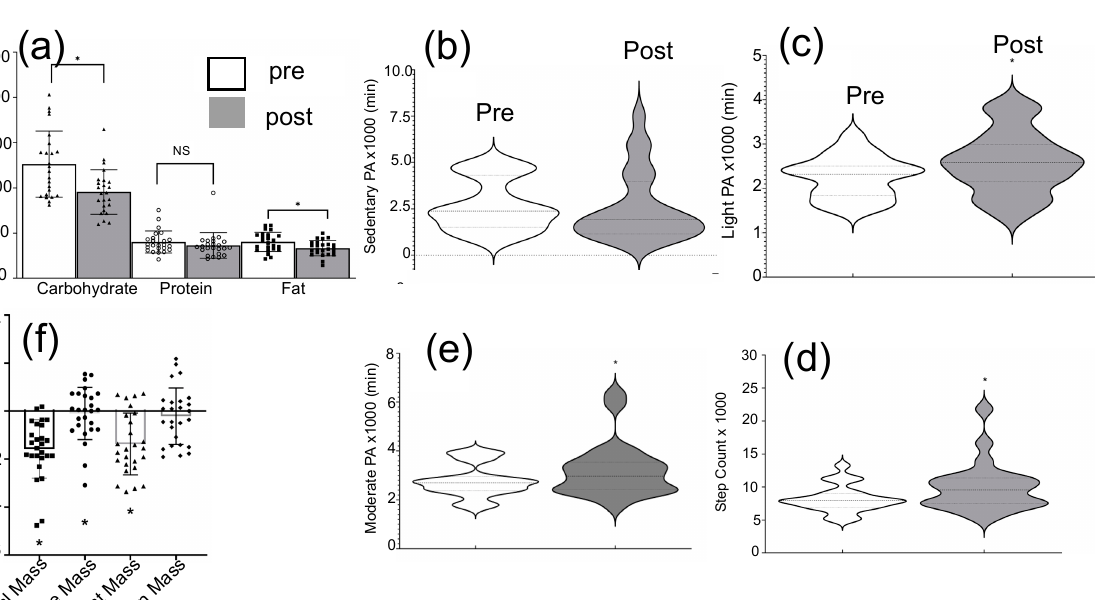
Figure 4. Variation of miRs − 140, − 935, − let − 7b, and − 99a, during the diet and exercise intervention. The change in molarity (post − pre) values were calculated. Molarity values were calculated using iLluminate for each miR target * p < 0.05.